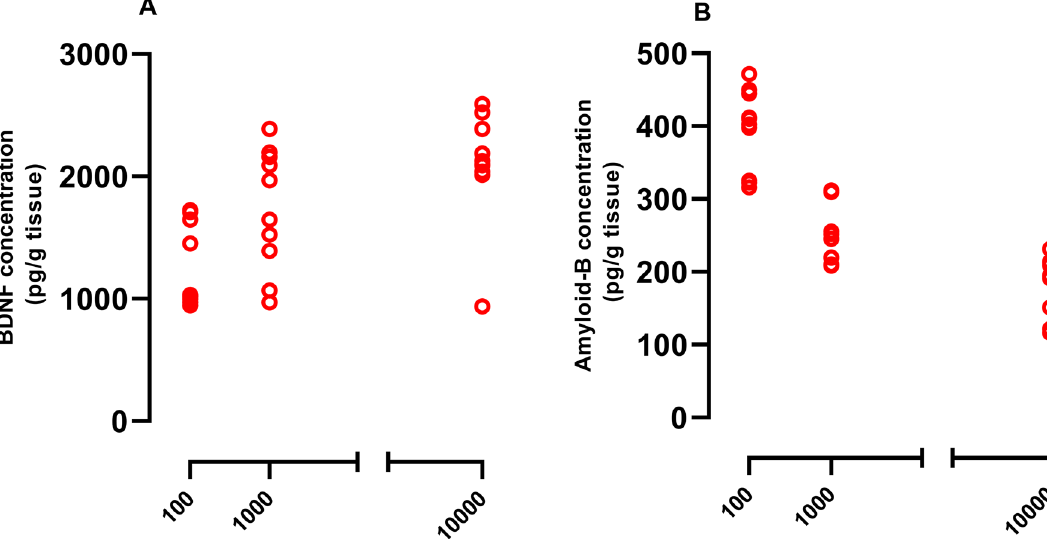
Figure 10. Correlation of Vit D doses with BDNF ( A ) and Aβ ( B ). As indicated, there is a positive correlations between doses of Vit D and BDNF (Pearson r = 0.5562, P < 0.01), however, this was found to be negative in case of Aβ levels (Pearson r = − 0.7080, P <